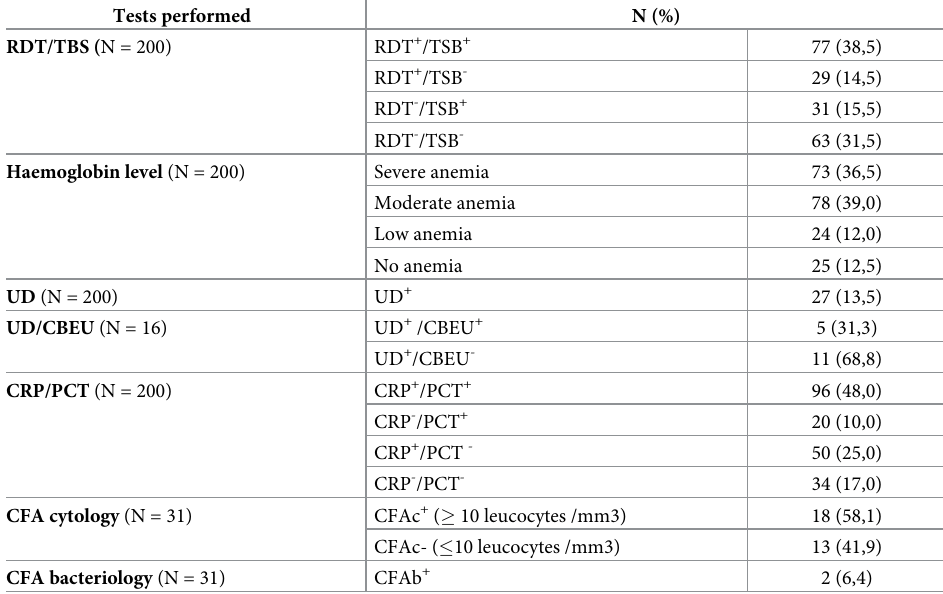
Table 3. Laboratory examinations of patients at the